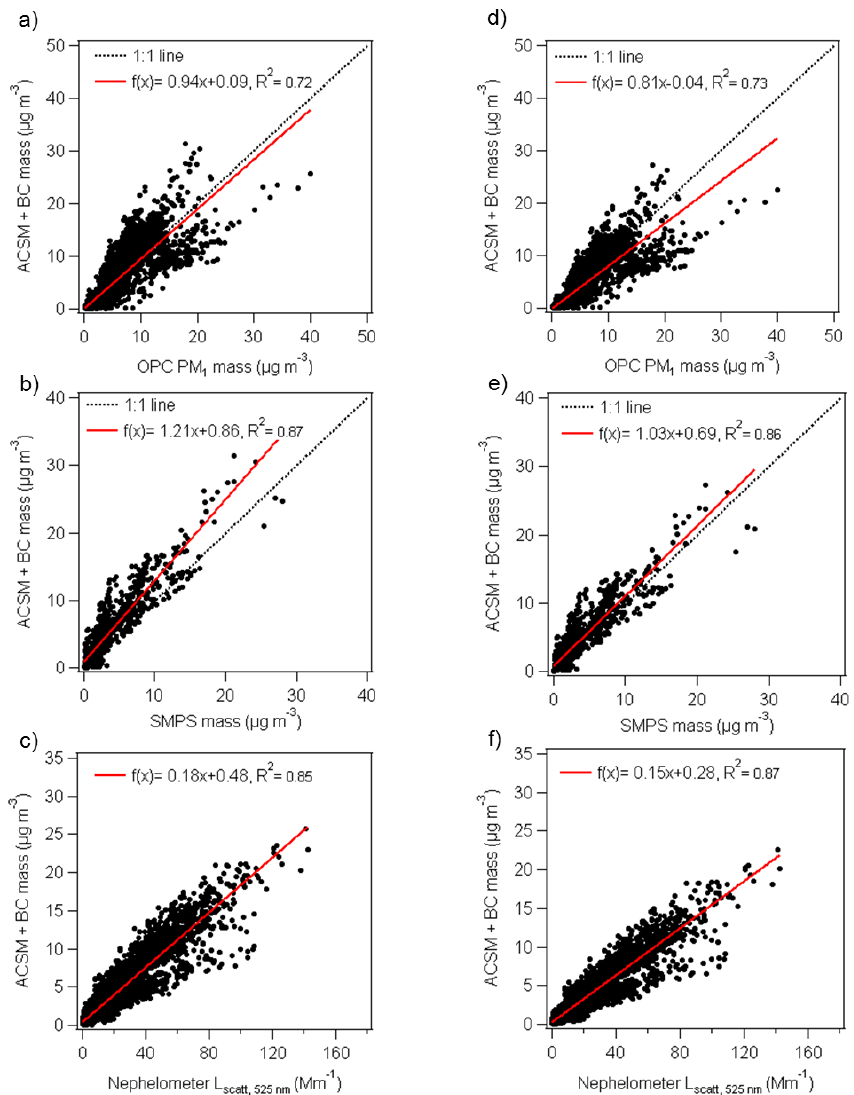
Figure 3. Scatter plots of ACSM plus BC mass vs. PM 1 from (a) OPC and (b) SMPS (winter campaign), and vs. light scattering at 525nm from (c) nephelometer. Scatter plots of ACSM plus BC mass after dividing OA by 1.54 vs. PM 1 from (d) OPC and (e) SMPS (winter campaign), and vs. light scattering at 525nm from (f) nephelometer. Data points correspond to hourly values. Equations and red lines correspond to linear regression